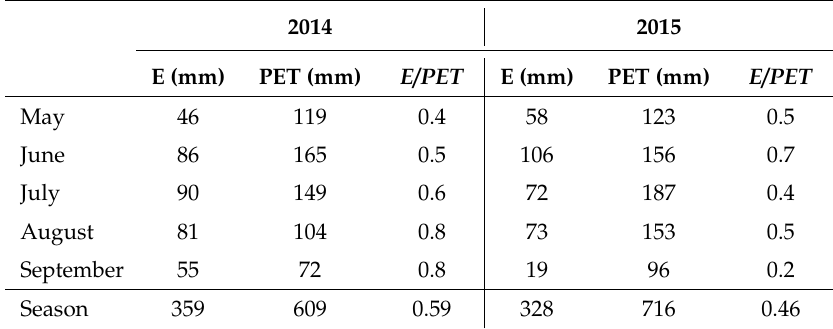
Monthly and seasonal (May–September) sums of transpiration ( E ) and potential evapotranspiration ( PET ) in years 2014 and 2015; the ratio E / PET